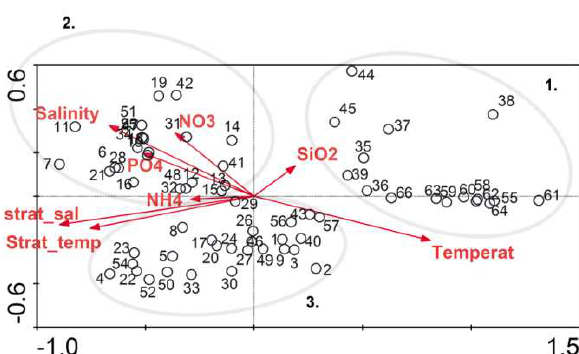
Fig. 10. Multidimensional scaling plot showing the distances (in terms of similarities) between the sites in the Lena Delta and coastal regions. All depths were included in the analysis. Black lines indi- cate 60% similarity contours. The arrow is pointing to the cluster containing all Lena Delta sites, T3 and three samples from stations 1 and 2 in transect 1 (the two stations closest to the coast).